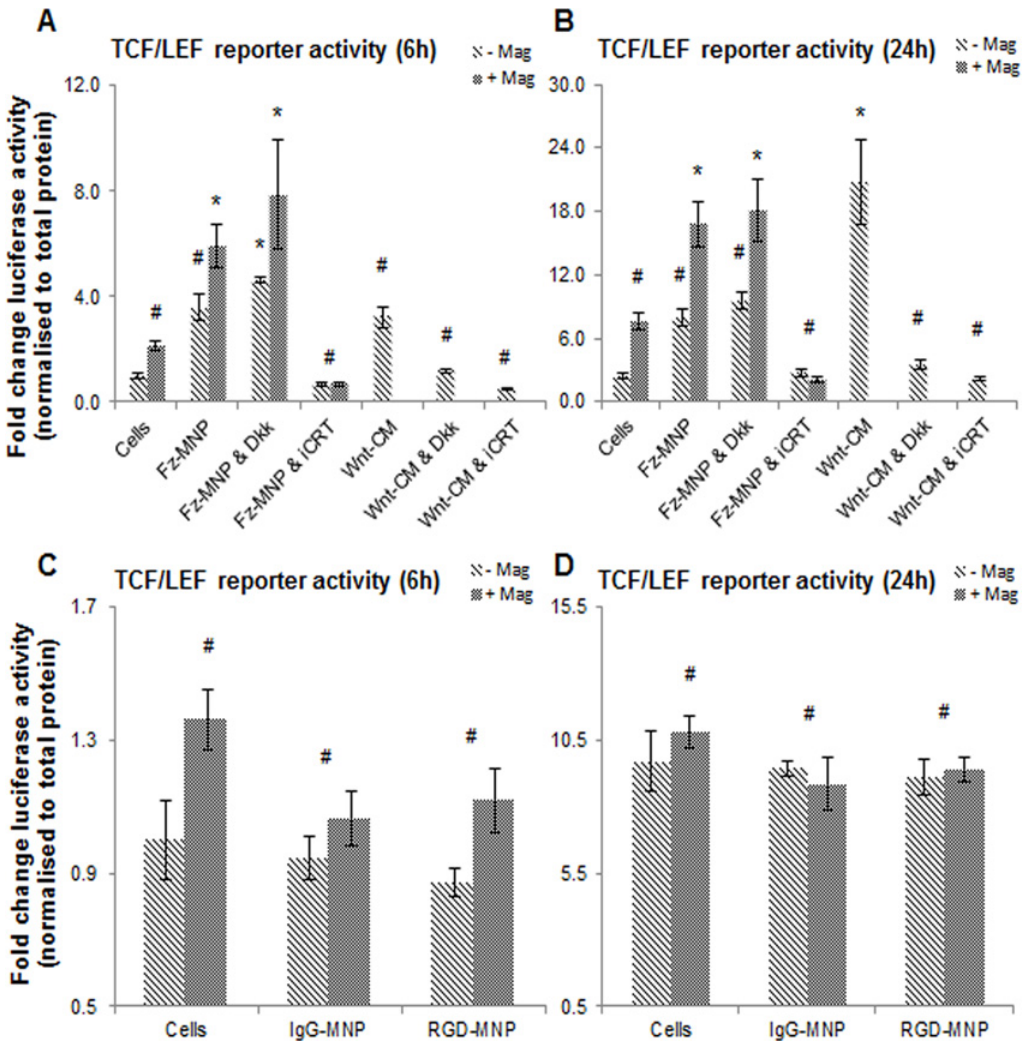
Fig 5. Anti-Frizzled particles activate a Wnt TCF/LEF luciferase reporter. TCF/LEF reporter activity from transiently transfected hMSC 6h and 24h after treatment. Magnetic field alone (hMSC + Mag) increased reporter activity at both time points (not significant) (A, B). Treatment with Frizzled particles (Fz- MNP) without magnetic field caused a noticeable increase in reporter activity over both time-points (trend only). An added significant increase in reporter activity was observed over both time-points when magnetic field was applied. Addition of the Wnt signalling blocker Dkk1 which inhibits LRP5/6 activation failed to prevent reporter activation by Fz-MNP. However activation was successfully blocked using the TCF/LEF inhibitor iCRT14, which inhibits Wnt signalling downstream of Frizzled. Treatment with Wnt-Conditioned Media increased reporter activity to a similar level as Fz-MNP (without magnet field) after 6h (A), with maximum activity observed after 24h (B). This effect was blocked using Dkk1 or iCRT14 with reporter activity being reduced to basal levels. Control particles coated with either Rabbit-IgG (IgG-MNP) or RGD peptide (RGD-MNP) caused no increase in reporter activity at 6h (C) or 24h (D) with or without magnetic field. Values represent mean fold change in luciferase activity relative to cells only with luciferase activity normalised to total protein. Error bars represent SEM, n = 4, * denotes p < 0.05, # denotes p (cid:1)